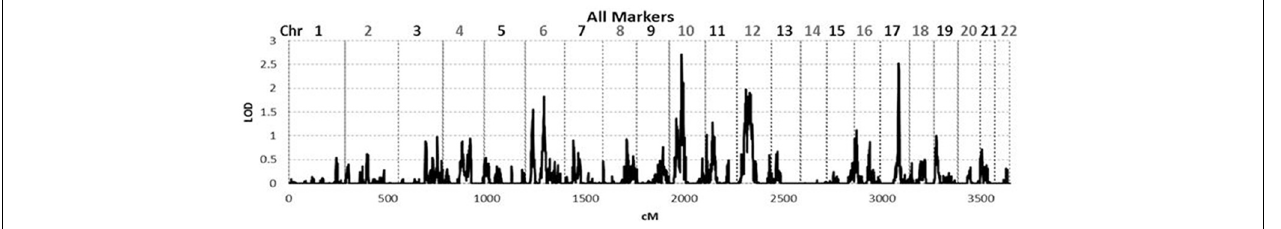
genes, namely RASGEF1A, HNRNPF, ANF487, CSTF2T, and PRKG1 for 10q11.21 ( Figures 3A,B ; Table 4 ). Two genes—